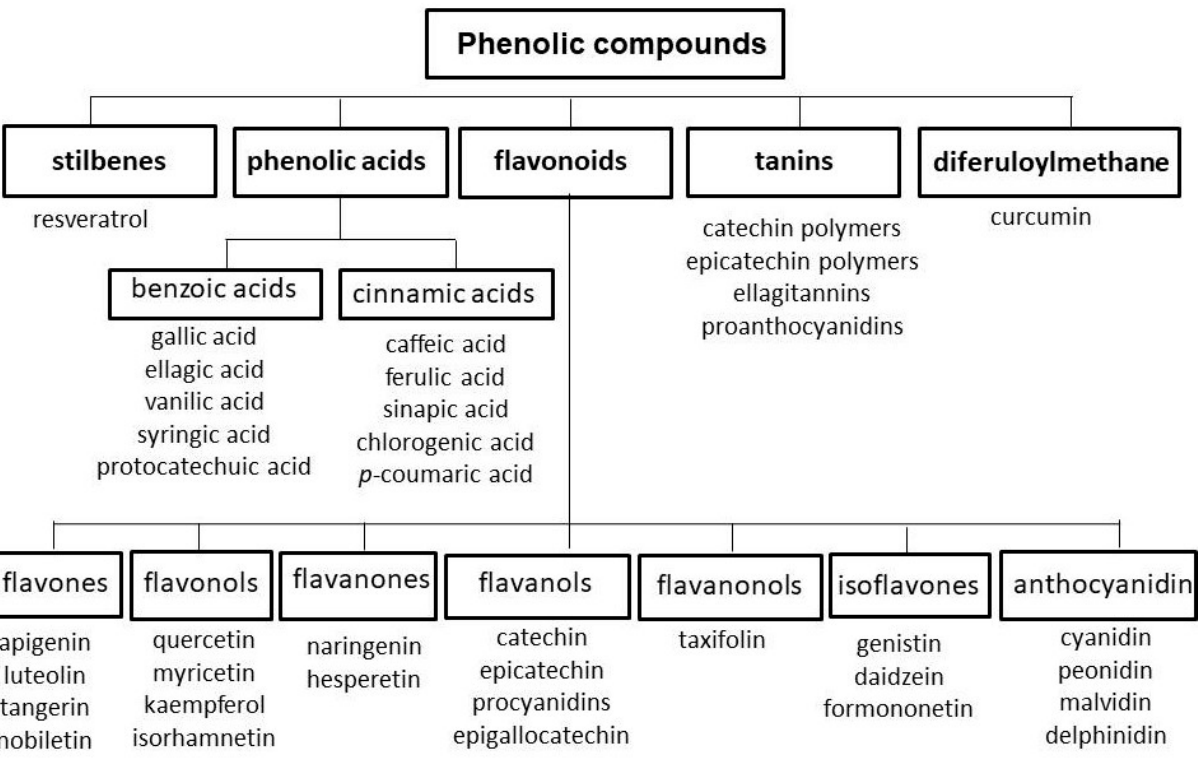
Figure 6. Classification of polyphenols (own work based on [190 ‒ 193]).